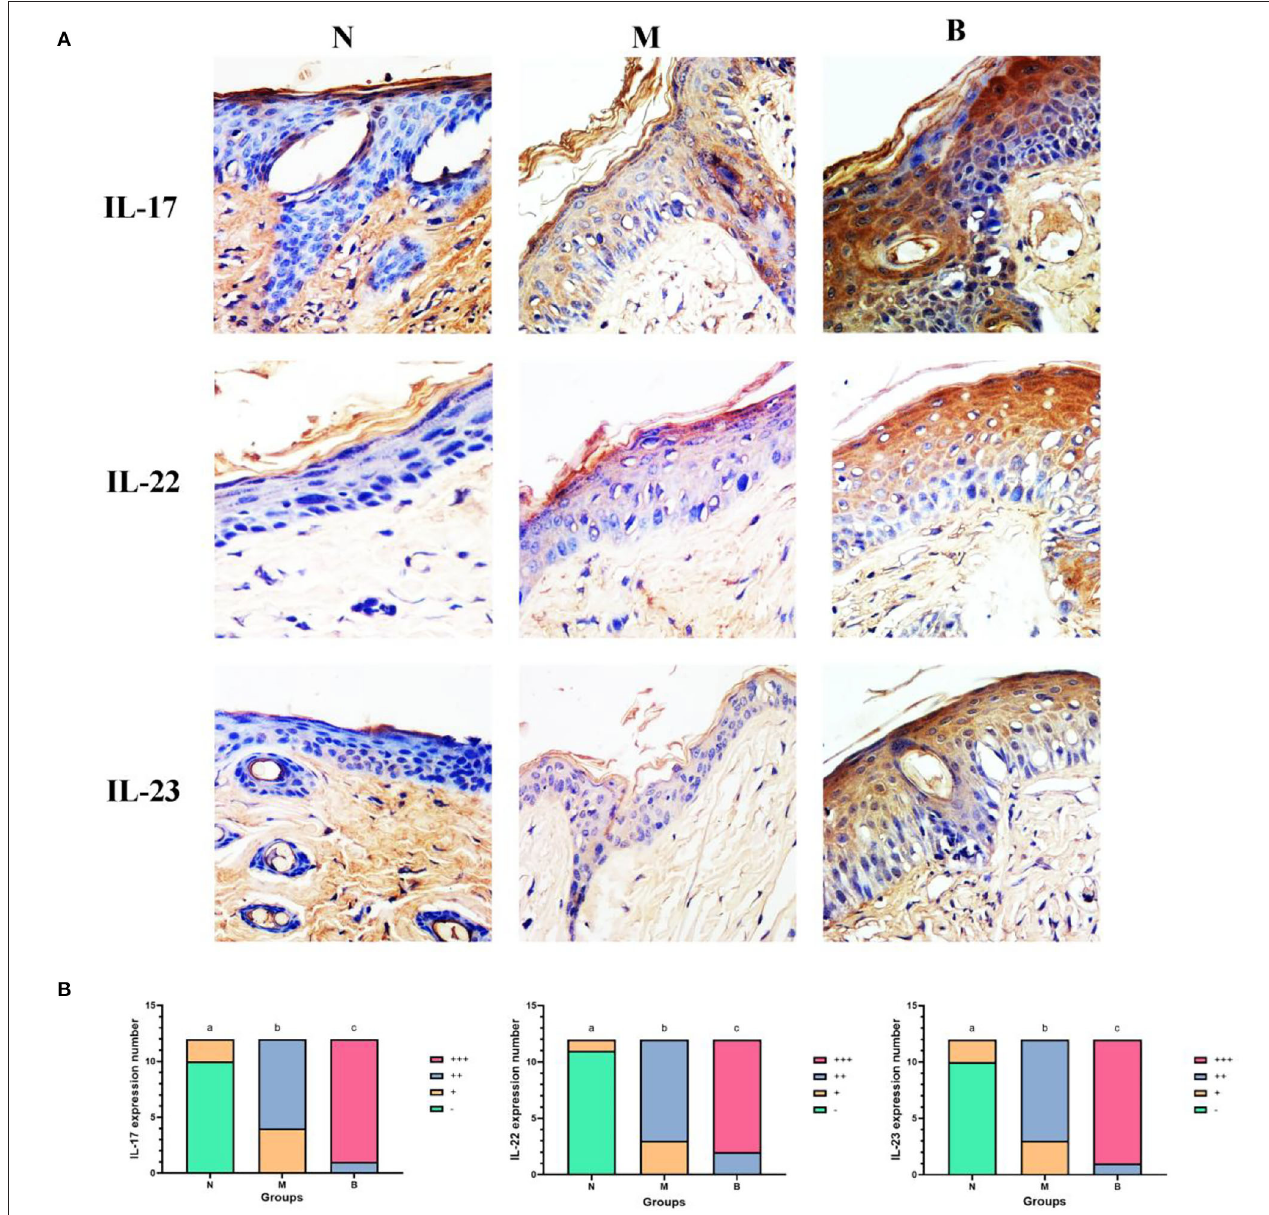
FIGURE 2 | (A) The expression of IL-17, IL-22, and IL-23 in the epidermis of each group. The positive color of these 3 cytokines is the coloring of the cytoplasm (light yellow to brown). Negative means no color development. These 3 factors are expressed in different degrees in keratinocytes, especially in spinous cells (400 × ). (B) The expression level of IL-17, IL-22, and IL-23 in the epidermis of each group of mice on day 7. Different lowercase letters between groups represent statistically significant differences. p < 0.05.